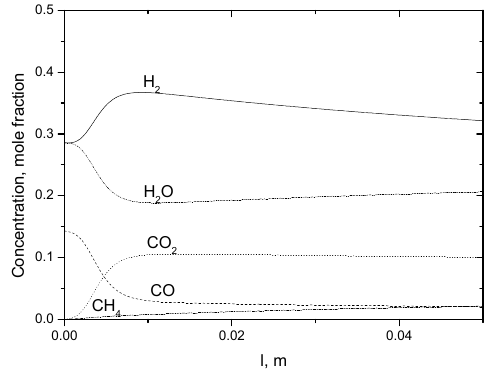
Figure 18. Species concentrations versus reactor length.